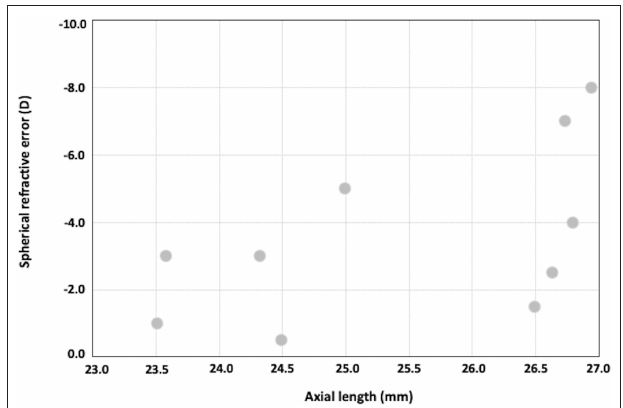
FIGURE 4 | Plots showing axial length vs. post-operative spherical refractive